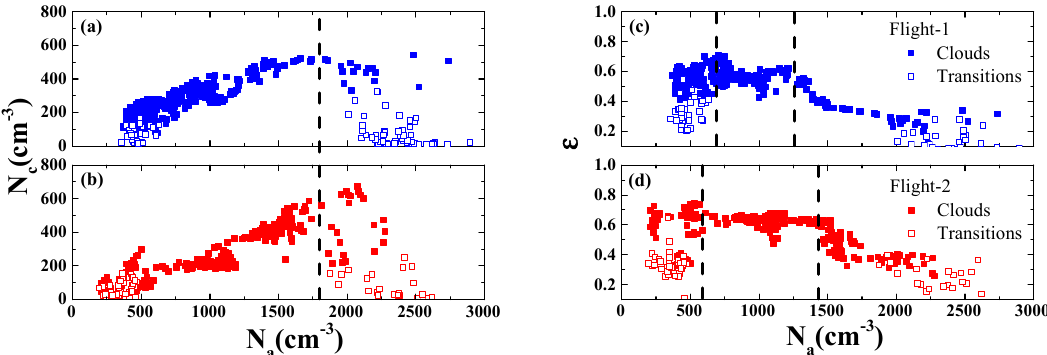
Figure 2. Relationships of cloud droplet concentration ( N c ) and relative dispersion ( ε ) to aerosol concentration ( N a ) in the two flights. ( a , c ) and ( b , d ) are for the first and second flights, respectively. The vertical lines indicate the N a values where the trends of N c − N a and ε − N a begin to change.